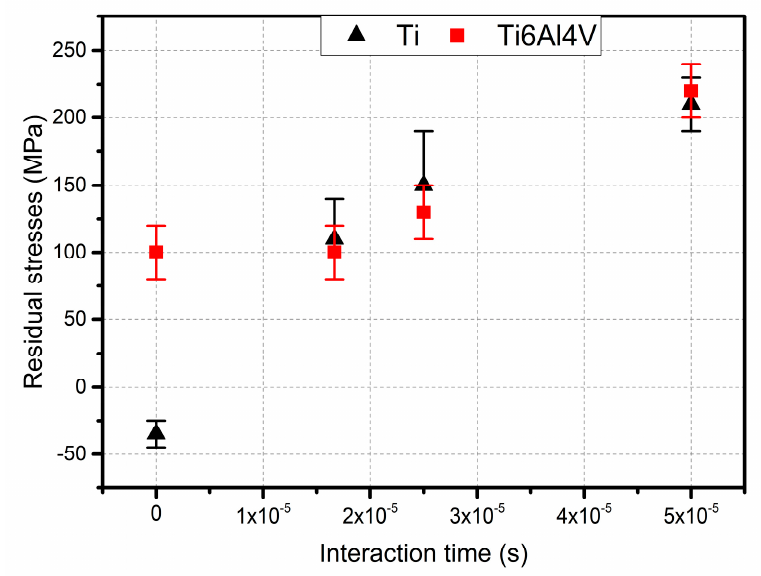
Figure 10. Residual stress in Ti and Ti64 samples before and after the SLT, determined with the sin 2 ψ method.